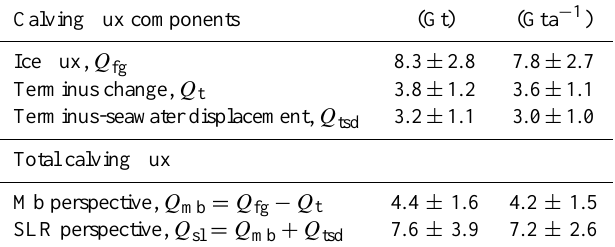
Table 1. Estimate of calving flux components and total calving flux over the TSX observation period from 19 April 2012 to 9 May